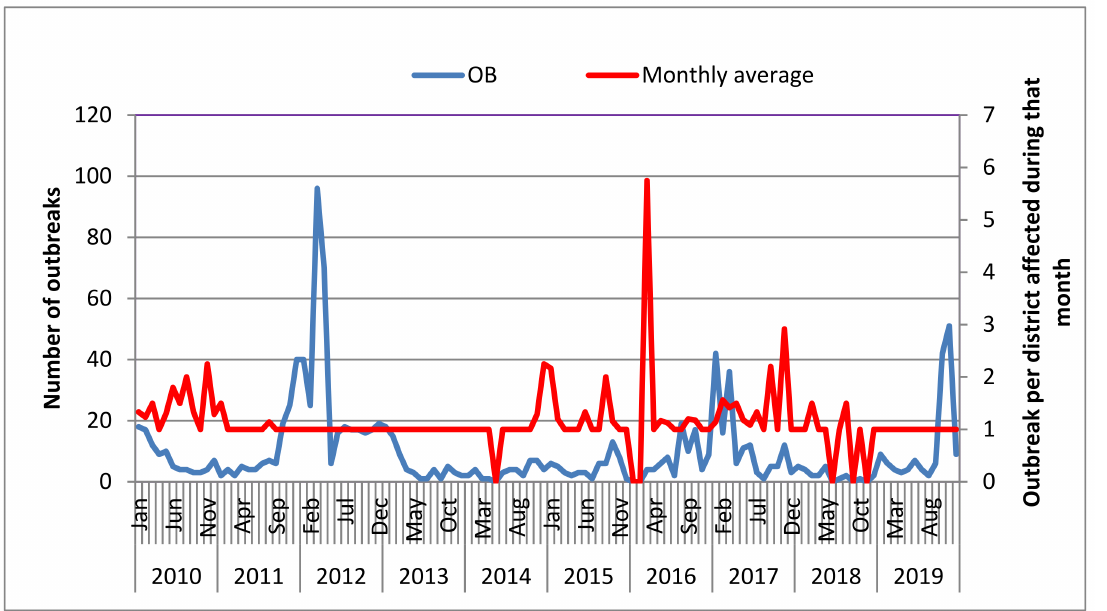
Figure 1. Outbreaks per district affected by one or more outbreaks during that month (indicated by the red line) and monthly outbreaks of FMD in Ethiopia over the period between 2010 and 2019. OB: outbreak (the number of outbreaks in each month is indicated by the blue line). Three peaks for outbreaks were observed in 2012, 2017, and 2019. Flat monthly averages, e.g., from September 2011 to March 2014, indicate that the number of affected districts is equal to the sum of the reported outbreaks.